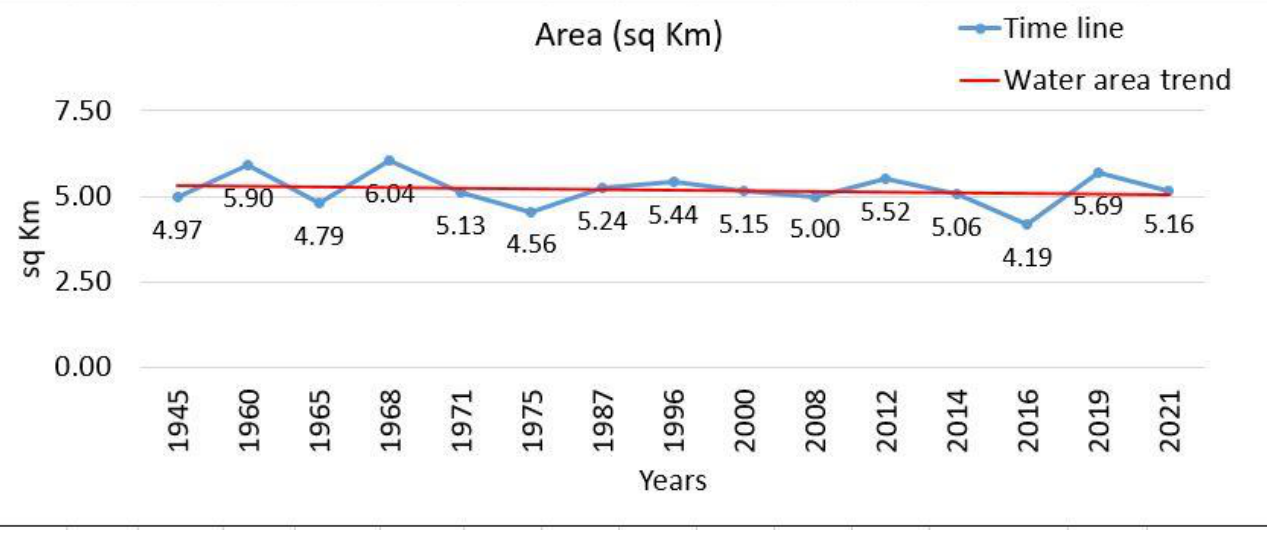
Figure 8. Water surface area fluctuations during the study period.